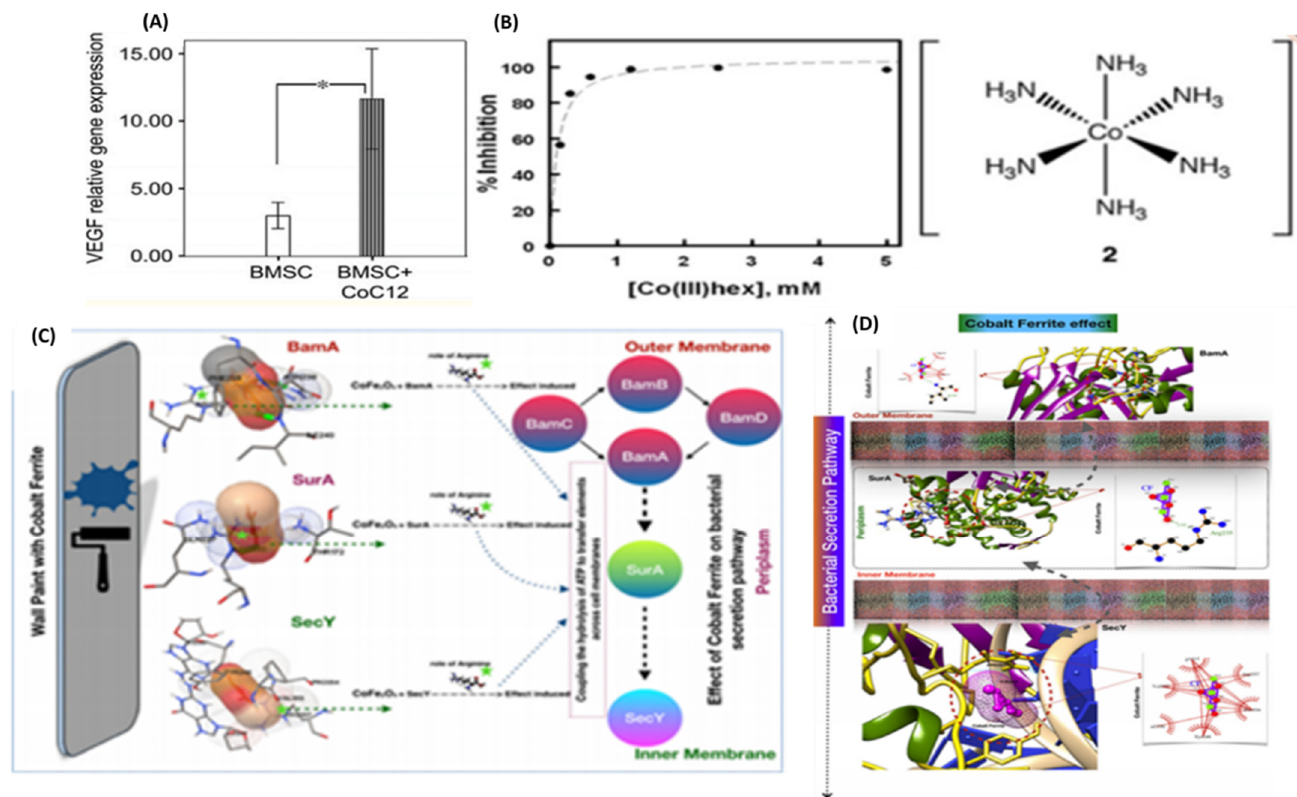
Figure 15. ( A ) showing VEGF expression of CoCl2-treated BMSCs vs untreated BMSC cells. ( B ) (right) shows the inhibitory effect of viruses on BHK cells treated with Cohex, and ( B ) (left) shows the structure of Cohex. Adapted from [242]. Reproduced with permission from MDPI. ( C ) shows the interaction of cobalt ferrite with BamA, SurA, and SecY proteins and their effects on bacterial metabolism. ( D ) shows the effect of cobalt ferrite on the bacterial secretion pathway through interaction with BamA, SurA, and SecY proteins as depicted by molecular docking and LIGPLOT. Adapted from [243]. Reproduced with permission from Elsevier.